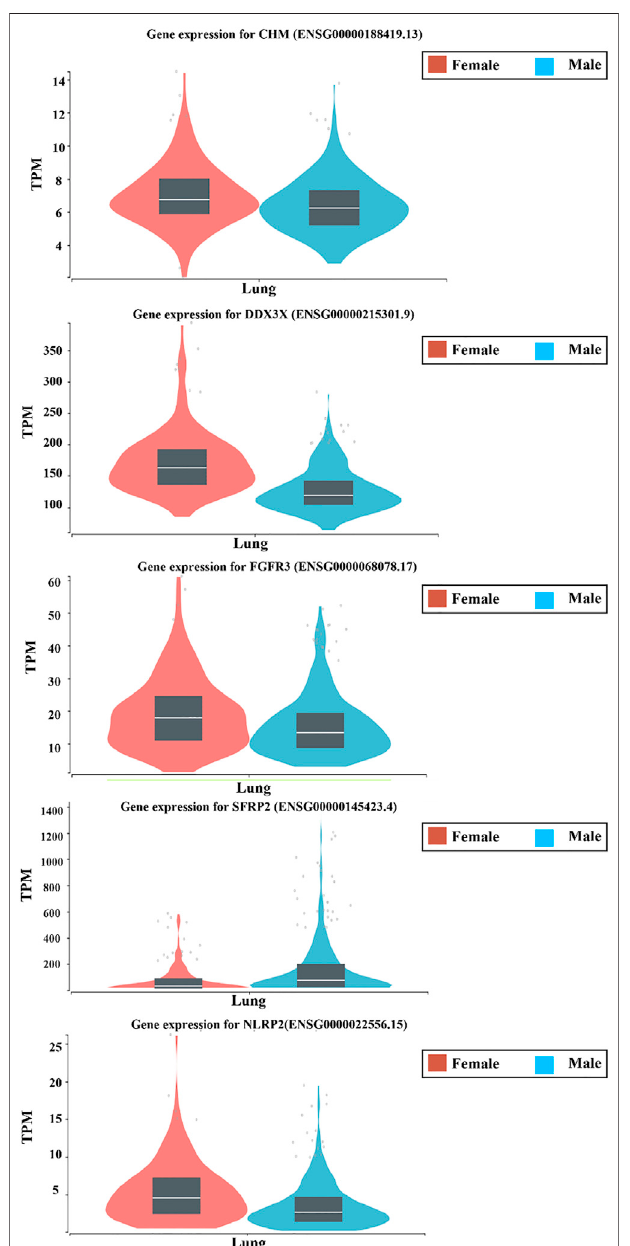
FIGURE 3 | The expression level of different genes related to the lung hydrolase activity between males ’ and females ’ lung tissues using The Genotype-Tissue Expression (GTEx) project (www.gtexportal.org) portal.